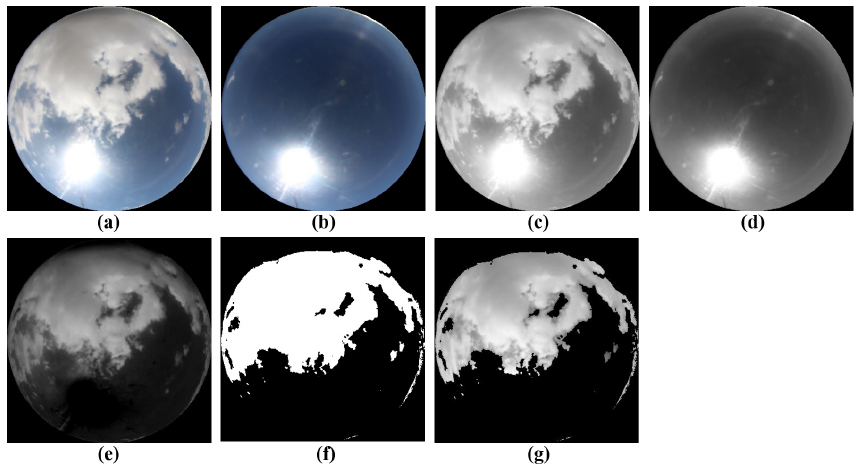
Figure 6. Cloud extraction result. (a) Original ASC image, (b) real clear background image with the same solar elevation angle as (a) , (c) grayscale image of (a) , (d) grayscale image of (b) , (e) difference of (c) and (d) , (f) cloud detection result, and (g) cloud extraction